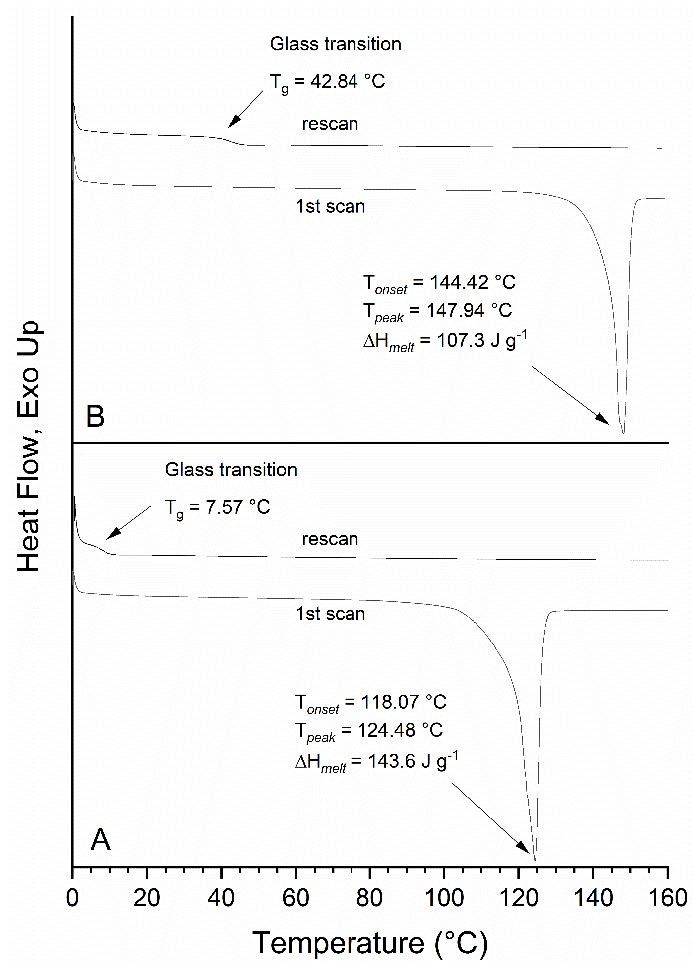
Figure 5. Differential scanning colorimetry of pure: ( A ) FG and ( B ) F 2 G. Figure 5. Di ff erential scanning colorimetry of pure: ( A ) FG and ( B ) F 2 G.